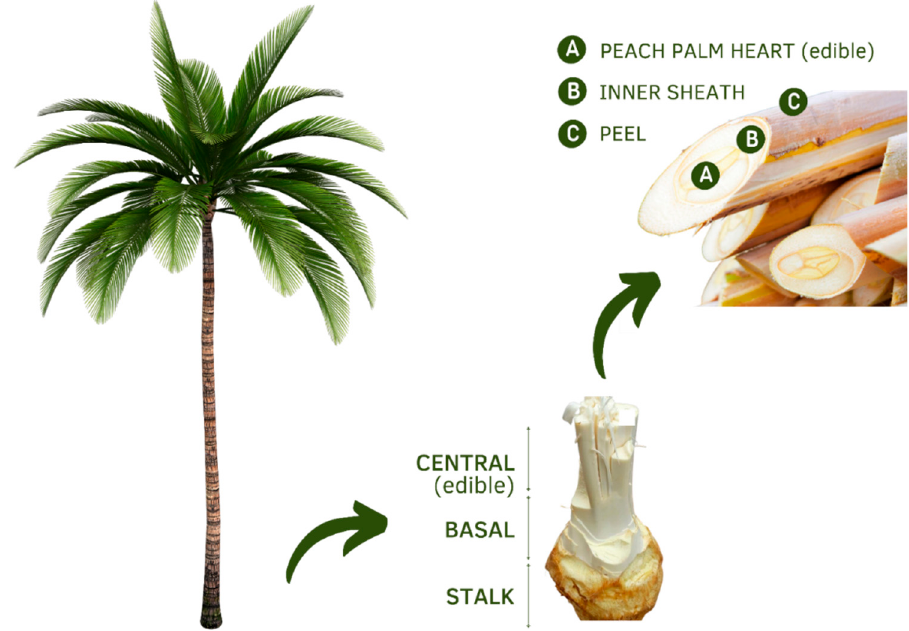
Figure 2. Bactris gasipaes palm stalk with its parts identified.